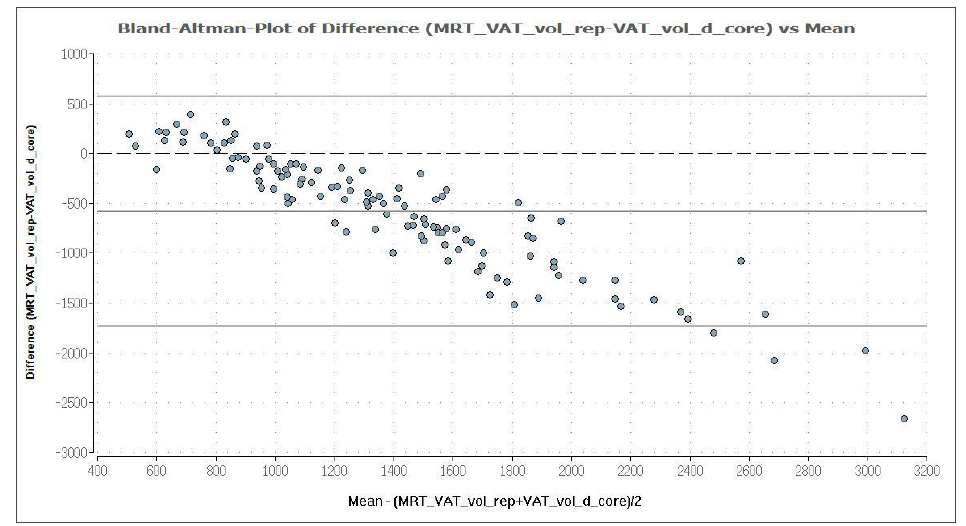
Figure 9. Bland–Altman plot of VAT volume (in cm 3 ) measured by DXA in “thick” mode Figure (VAT_vol_d_core) and MRI (MRT_VAT_vol_rep). The mean and the difference of both methods are